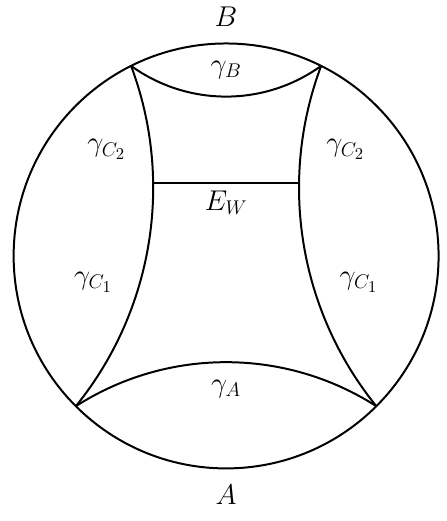
Figure 35 . The holographic setting described by the two-tensor